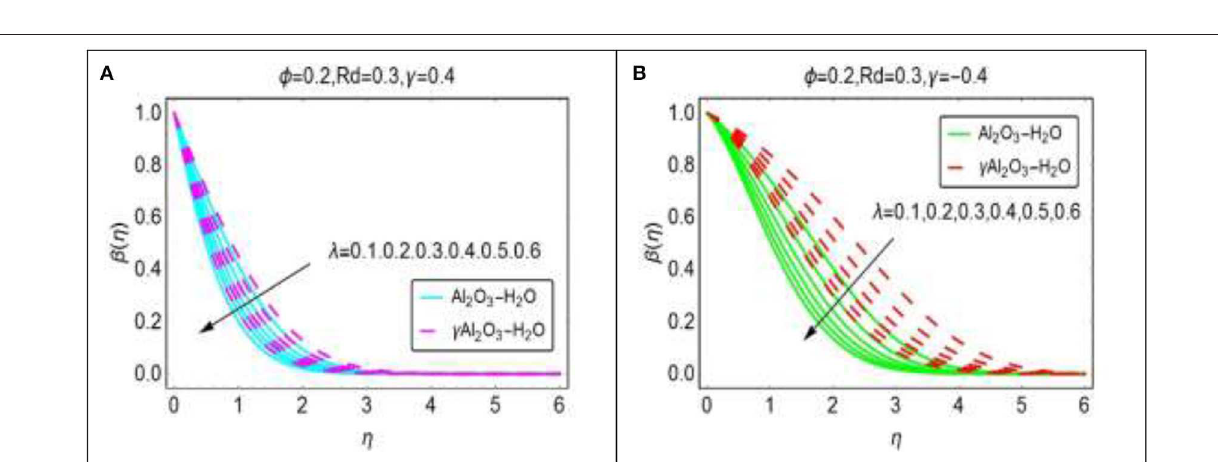
Frontiers in Physics |